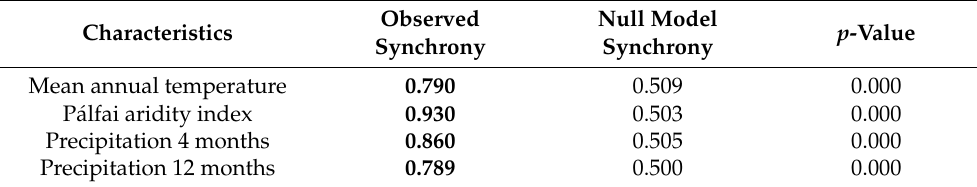
Table 1. Synchrony of weather characteristics among sites. Bold numbers indicate significant associations.